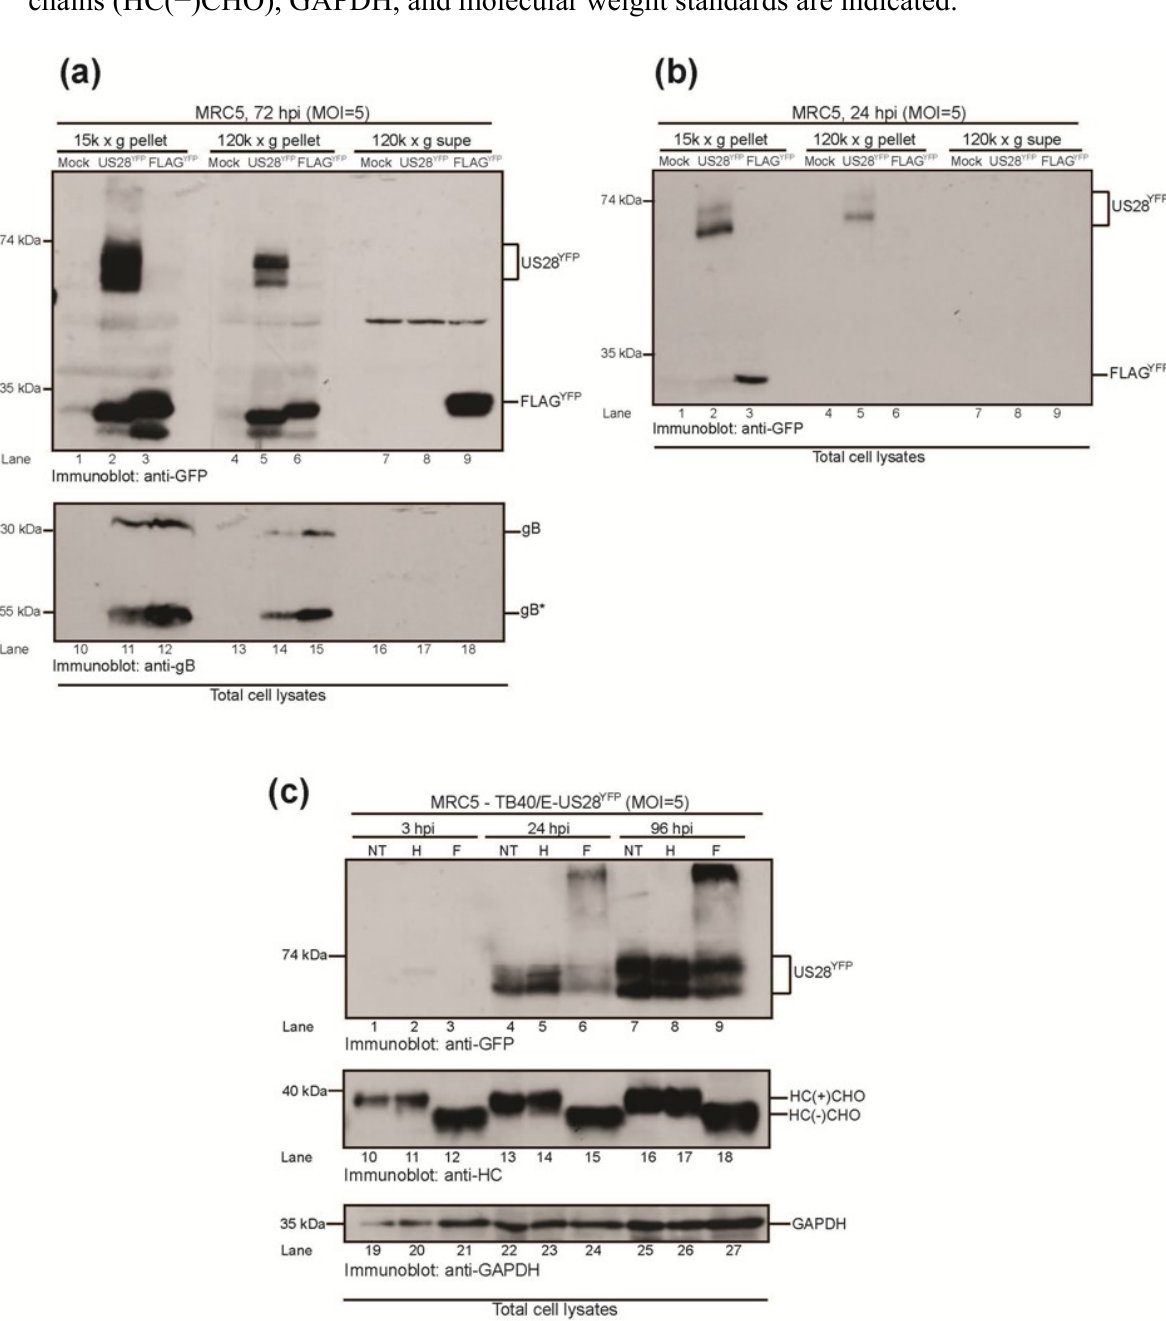
Figure 3. HCMV US28 is a non-glycosylated membrane protein incorporated into infected cells. Fibroblasts mock-infected or infected (MOI = 5) with either TB40/E-US28 YFP or TB40/E-FLAG YFP were subjected to subcellular fractionation at 72 ( a ) or 24 ( b ) hours post-infection. Cell pellets from the 15,000 and 120,000 × g centrifugations (15 k × g pellet, 120 k × g pellet) and the 120,000 × g supernatant (120 k × g supe) were resolved by SDS-PAGE and subjected to immunoblot analysis. US28 YFP , FLAG YFP , gB, and molecular weight standards are indicated. gB* indicates the mature form of glycoprotein B. ( c ) Fibroblasts infected with TB40/E-US28 YFP (MOI = 5) were harvested at the indicated time points and left non-treated (NT) or treated with EndoH (H) or PNGaseF (F). US28 YFP , glycosylated MHC class I heavy chains (HC(+)CHO), deglycosylated MHC class I heavy chains (HC(−)CHO), GAPDH, and molecular weight standards are